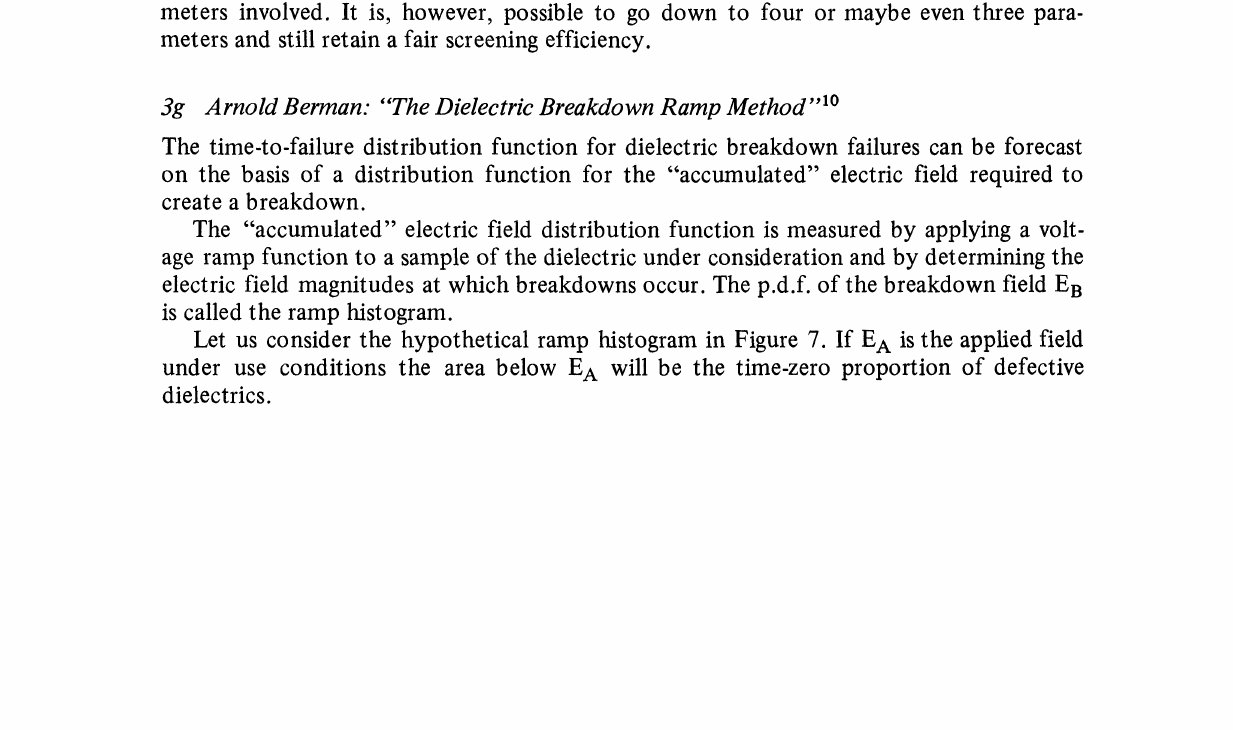
FIGURE 6 Correlation between DF-screening and results from life tests on lip